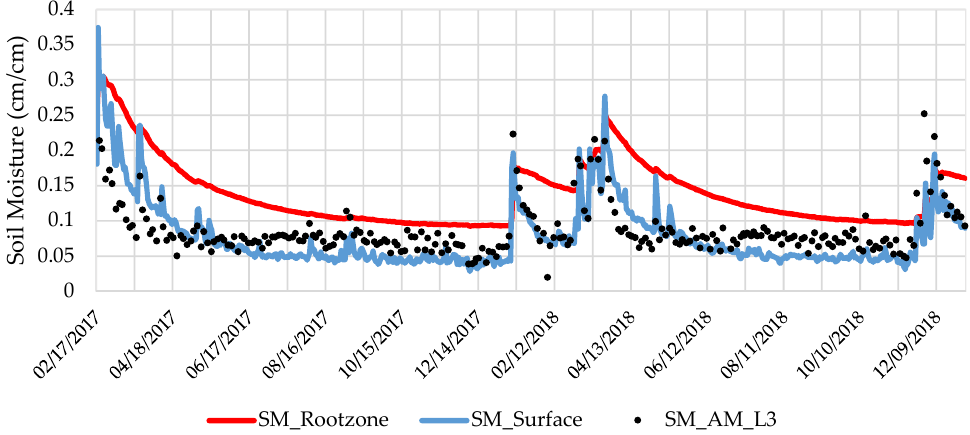
Figure 10. SMAP level 3 soil moisture measurements of AM passes (black dots), SMAP level 4 surface soil moisture derivation (blue solid line), and SMAP level 4 root zone soil moisture derivation (red solid line).